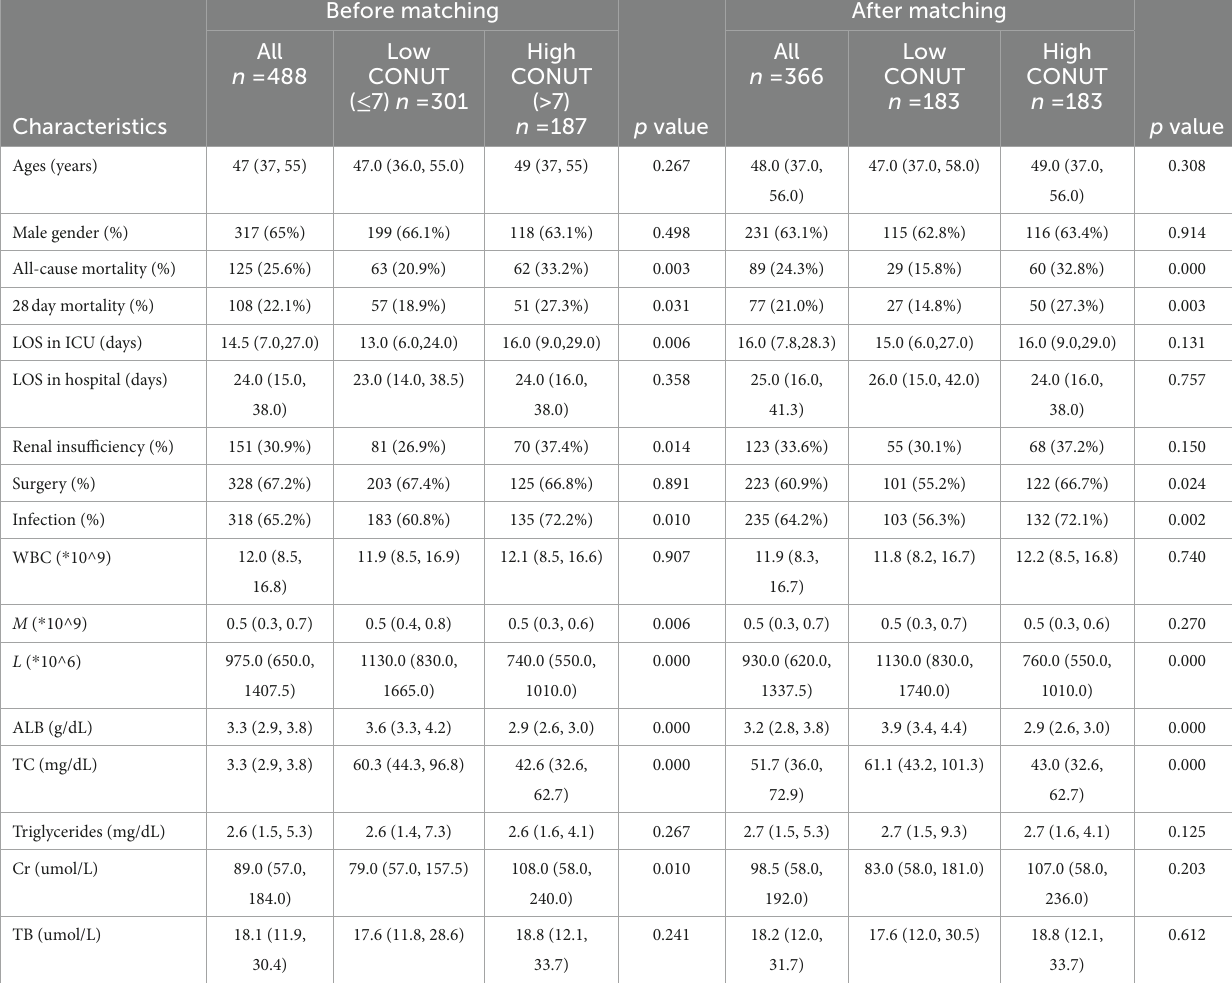
TABLE 1 Demographic and baseline characteristics of patients with severe acute pancreatitis.